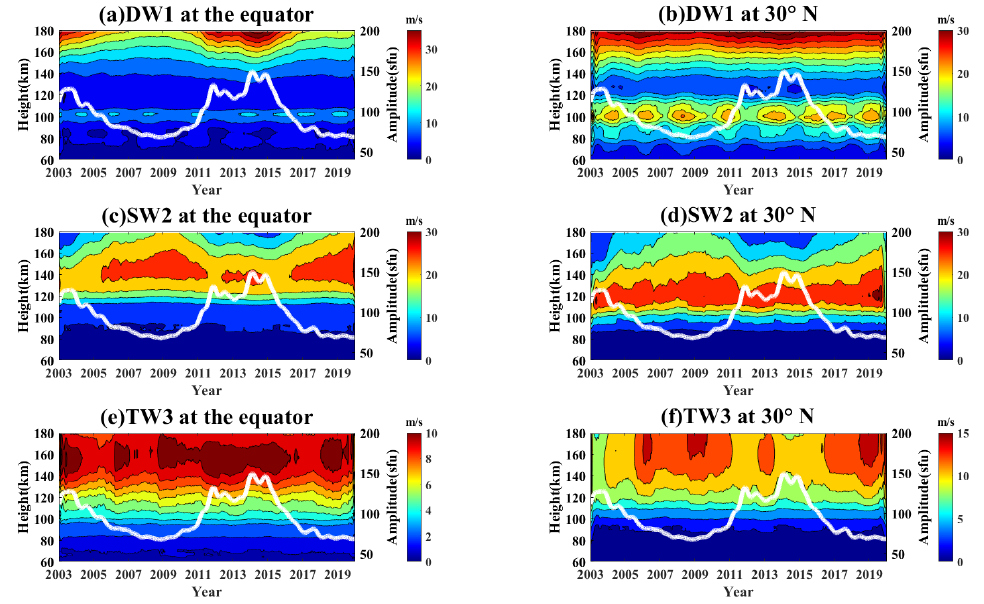
Figure 1. Migrating tidal variations from 2003 to 2019 for ( a , b ) DW1, ( c , d ) SW2, and ( e , f ) TW3 at ( a , c , e ) equator and ( b , d , f ) 30 ° N. The white solid line presents the daily mean F10.7 cm index from 2003 to 2019.